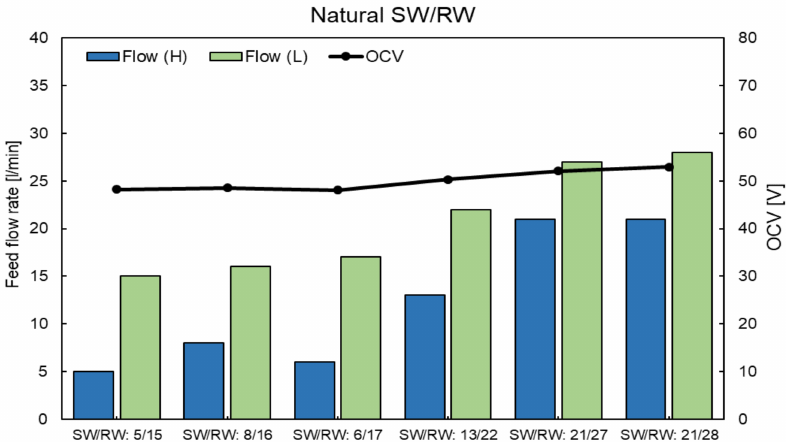
Figure A7. OCVs of RED stack using natural SW and RW feed solutions at different feed flow rates.